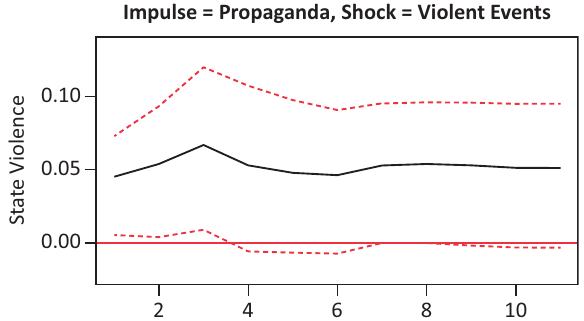
Figure 2. Impulse response function of propaganda on state violence,